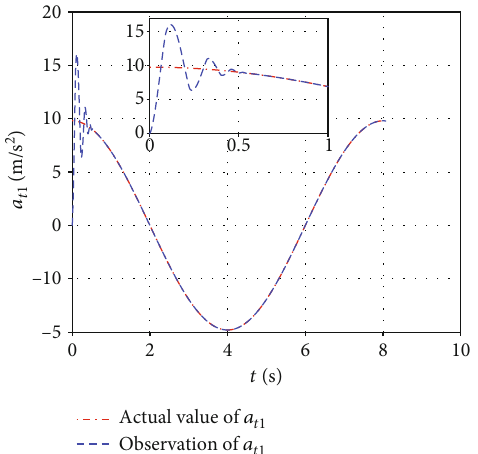
Figure 32: Ranges between the missile and the target.